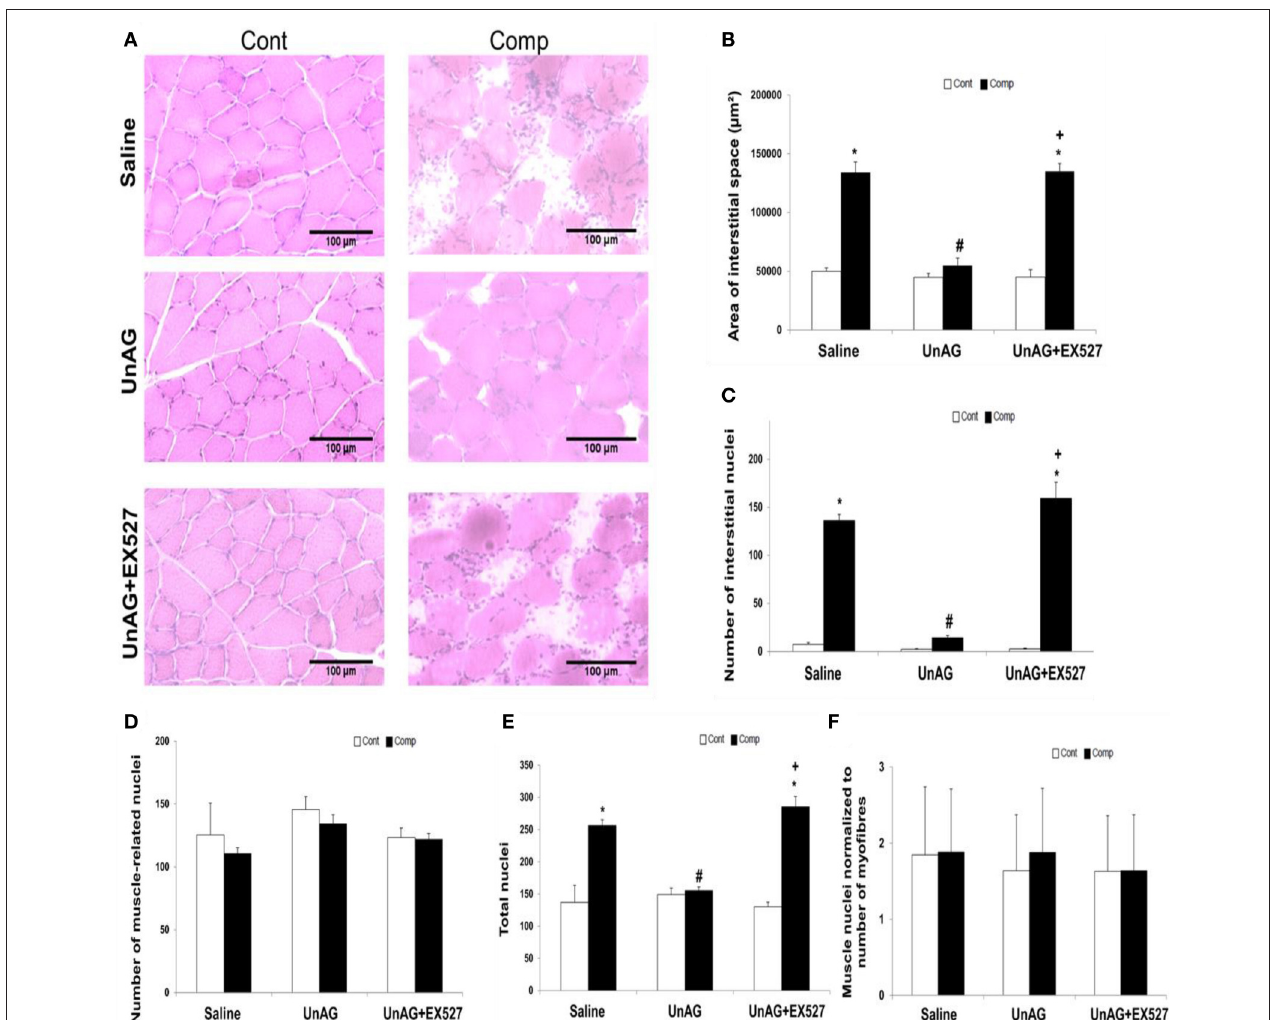
FIGURE 1 | Histological analyses. UnAG abolished abnormal muscle histology induced by moderate compression but this effect was vanished when co-treated with EX527 (A) . The elevation of area of interstitial space induced by compression injury was alleviated by UnAG (B) . The reduction of the number of interstitial nuclei induced by UnAG in the compressed muscle was mitigated by the co-treatment of EX527 (C) . No compression or treatment effect was observed for the number of muscle-related nuclei (D) . The total number of nuclei was significantly different between compressed and uncompressed muscles in all groups except in the group treated only with UnAG (E) . Neither compression nor drug treatment affected the number of muscle nuclei normalized to the number of myofibers (F) . * p < 0.05, compressed muscle compared to uncompressed control muscle; # p < 0.05, UnAG compared to Saline; + p < 0.05, UnAG + EX527 compared to UnAG; Cont, control muscle; Comp, compressed